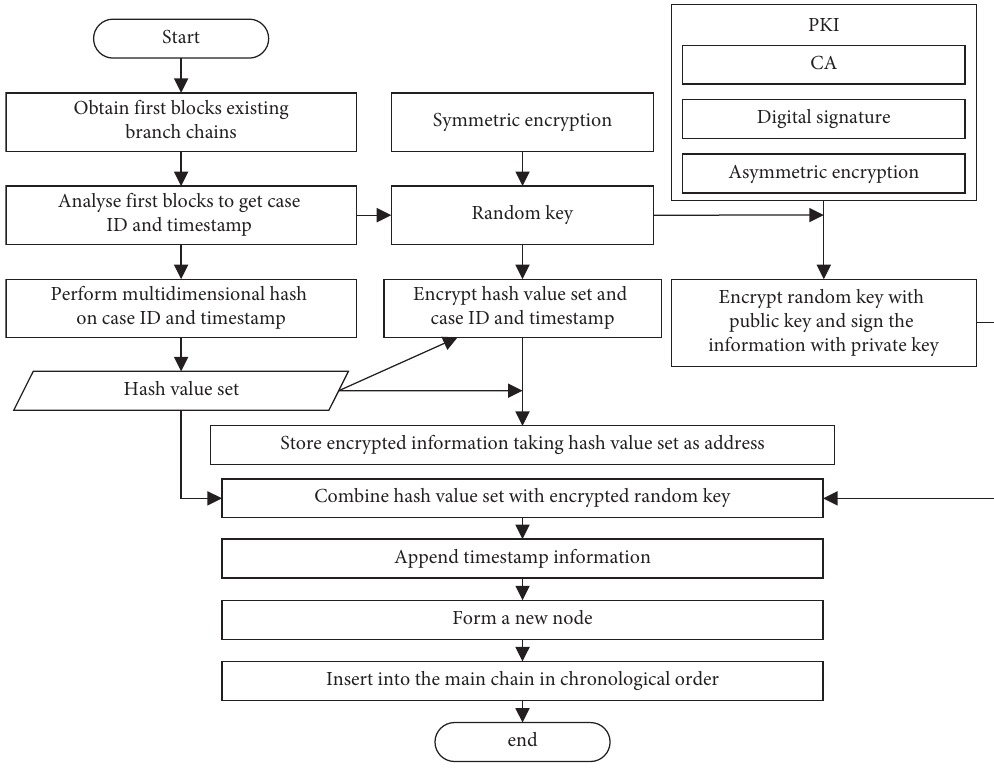
Figure 7: Process of building main